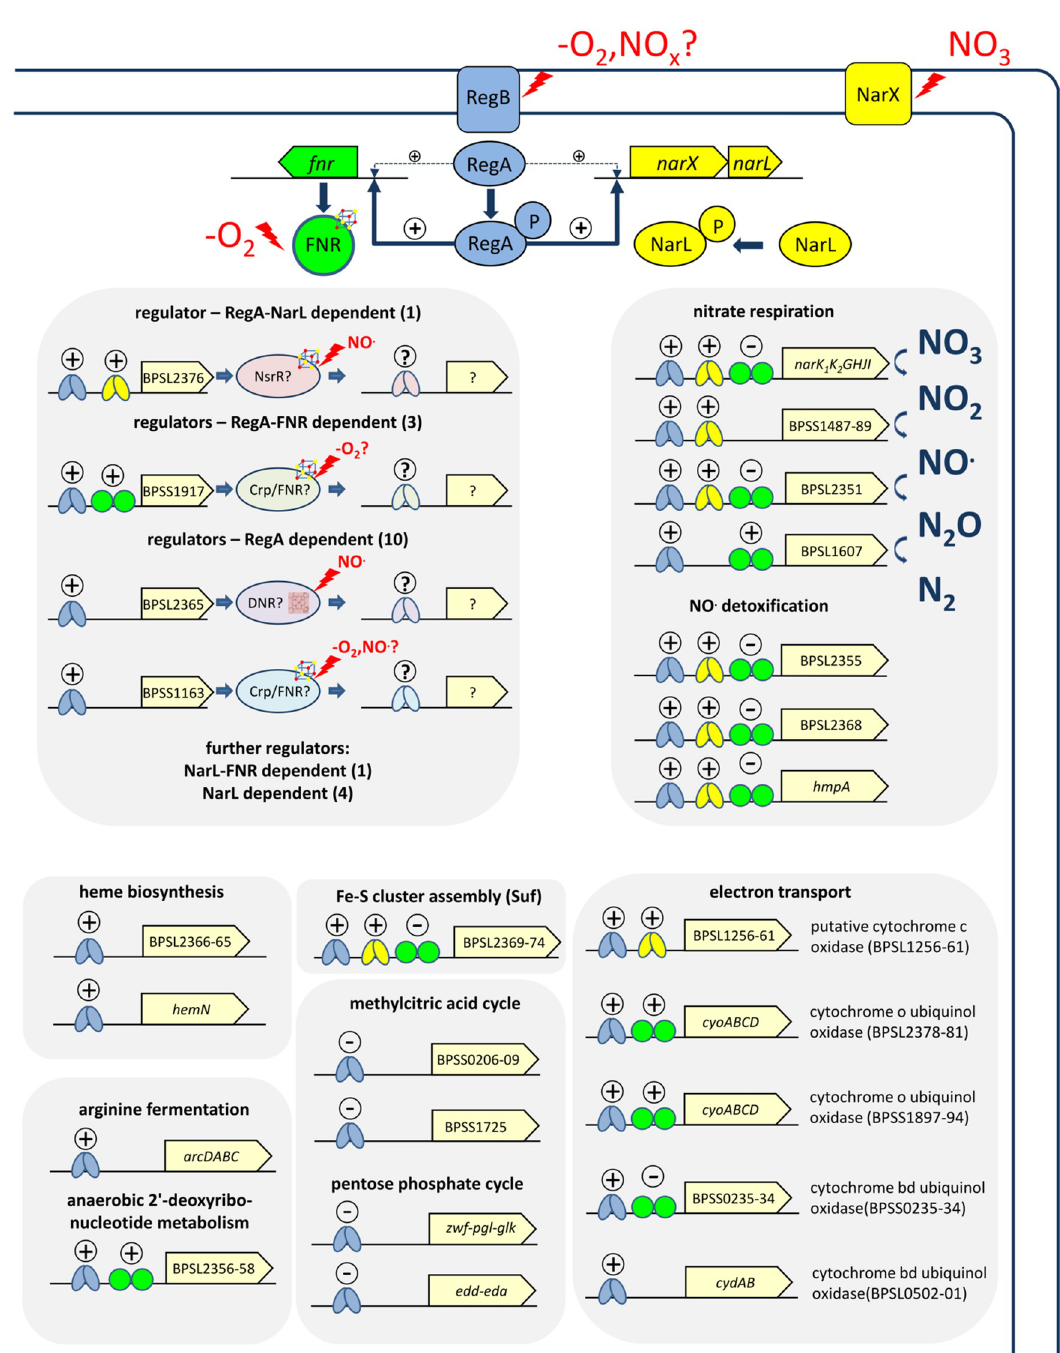
Fig 8. Preliminary regulatory model of gene expression during anaerobiosis in B . pseudomallei . Under normoxic conditions the RegAB TCS positively influences the gene expression of transcriptional regulators like the NarXL TCS and FNR as well as few other genes (not shown) on a low basis level. It ensured their presence and maintained their regulatory function under all growth conditions. Under anaerobic conditions (-O 2 ), the RegB sensor kinase is activated and phosphorylates the RegA response regulator leading to a strong transcriptional activation of the NarXL TCS, FNR and further regulatory systems. Altogether their expression and simultaneous functional activation by the lowered redox potential and presence of nitrate (NO 3- ) and/or different intermediates of nitrate degradation (e.g. NOx, NO) drives the regulation of genes involved in nitrate respiration, NO detoxification, alternative electron transport chains, heme biosynthesis, arginine fermentation, Fe-S cluster assembly, anaerobic nucleotide metabolism, methylcitric acid cycle and the pentose phosphate cycle. Blue symbolizes the RegA response regulator, green the FNR regulator and yellow the NarL response regulator. Plus signs indicate a putative role as activator, minus signs as a putative repressor and the